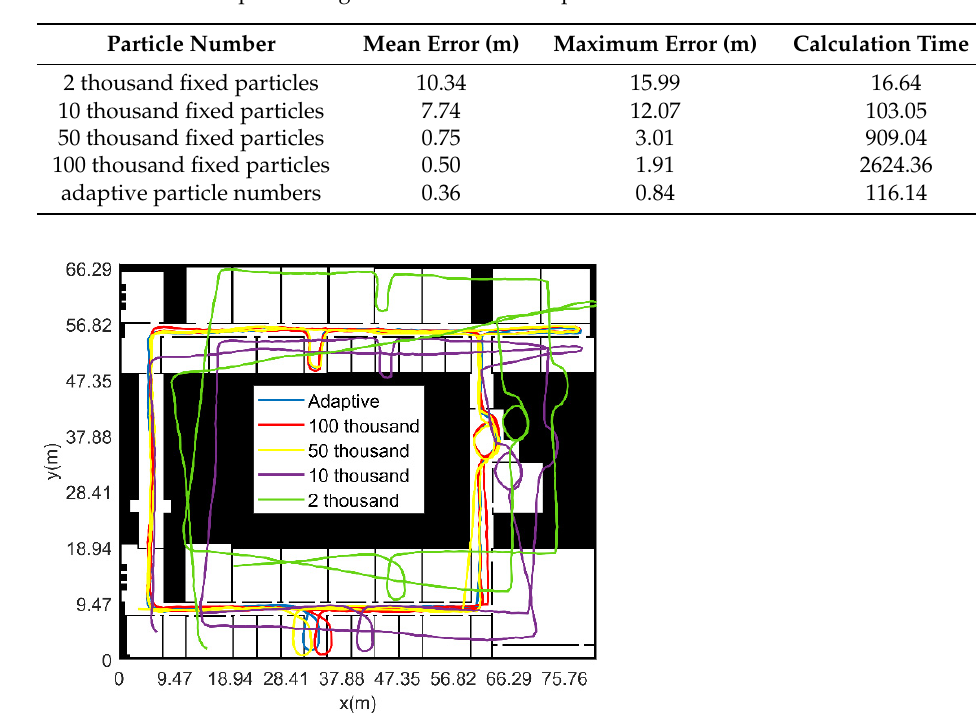
Table 3. Statistics of positioning errors with different particle numbers under simulation conditions.